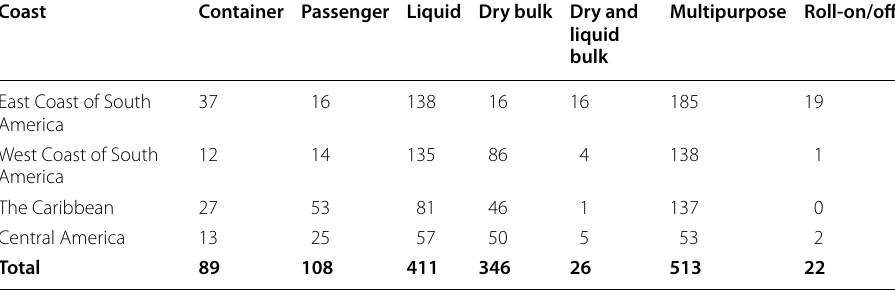
Table 1 Number of terminals by location and specialization. Source: CEPAL (2020)